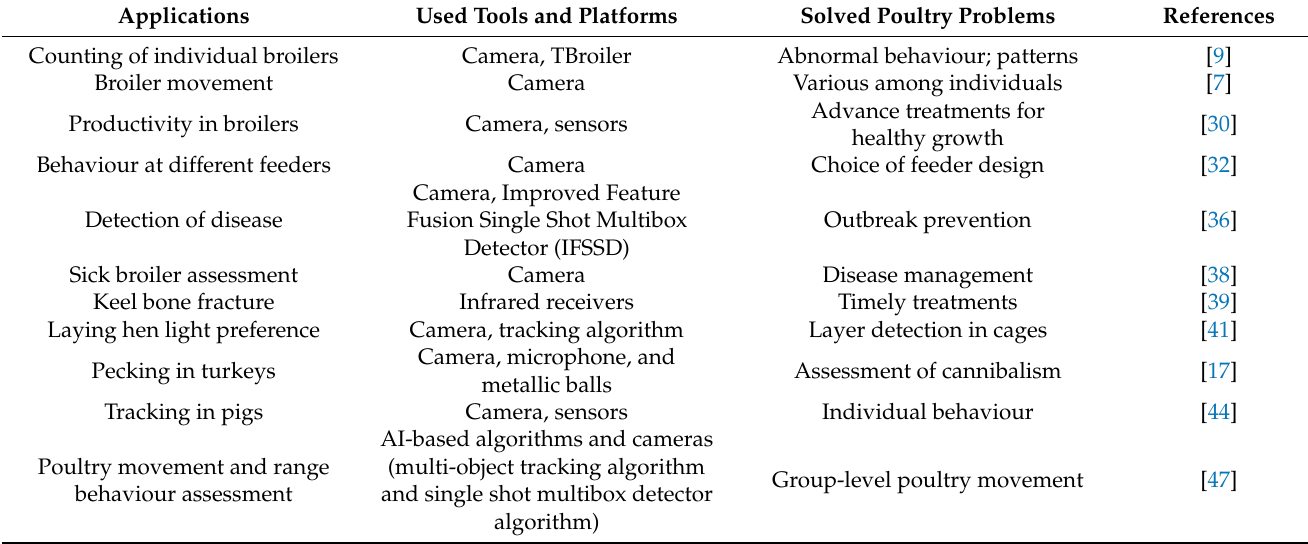
Table 1. An overview of current research advancements of automated poultry monitoring